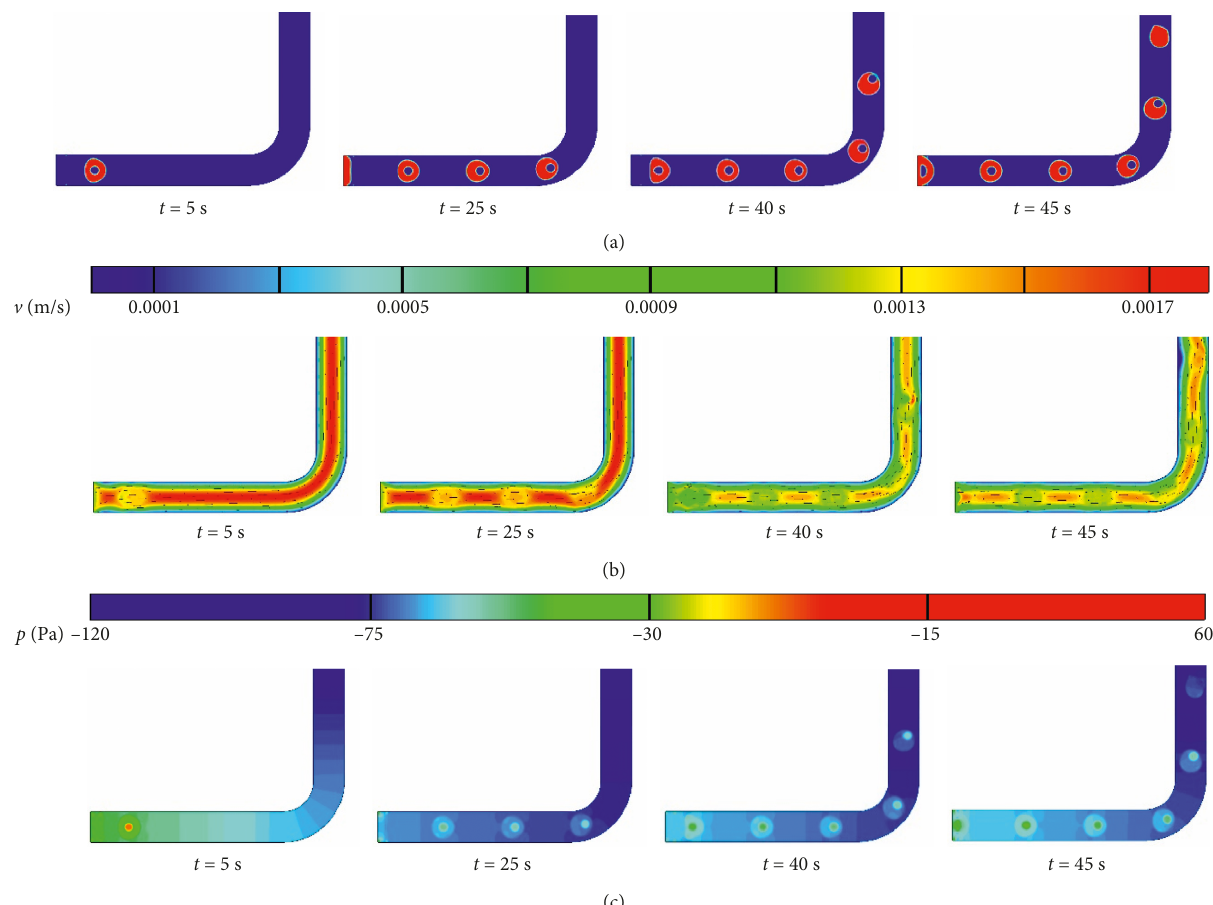
Figure 5: Time revolution of compound droplet deformation in the curved minichannel: (a) interface shape; (b) pressure distribution; (c) velocity